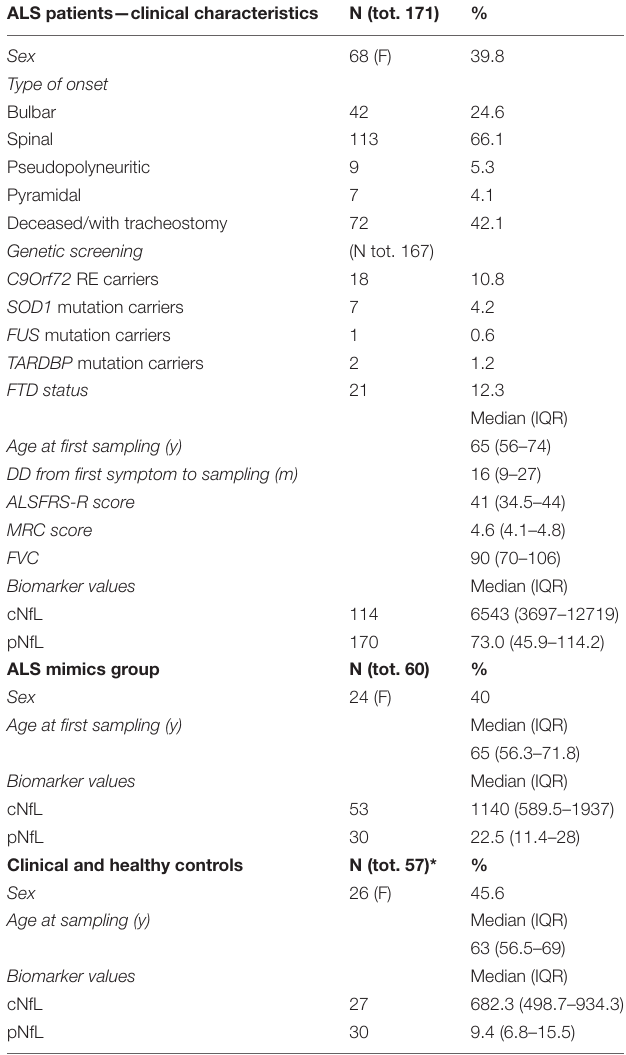
TABLE 1 | Demographic and clinical features of the study